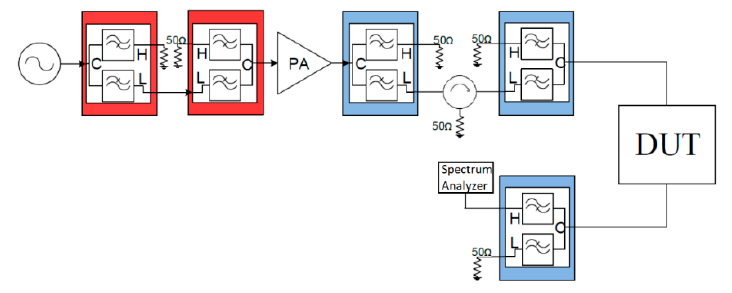
Figure 13. Test setup for harmonic through measurement.